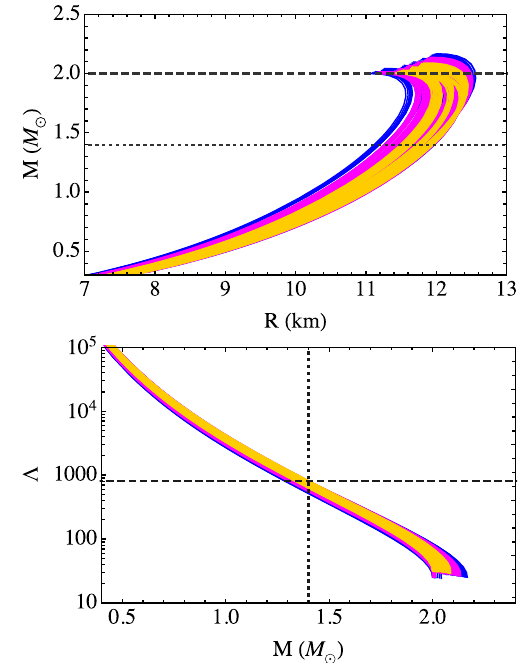
Fig. 3 Upper: mass-radius relations for strange quark stars. The black- dashed line stands for M = 2 . 0 M (cid:2) , and the black-dotted line stands for M = 1 . 4 M (cid:2) . Lower: (cid:2) -mass relations for strange quark stars. The black-dashed horizontal line stands for (cid:2) = 800, and the black-dotted vertical line stands for M = 1 . 4 M (cid:2)